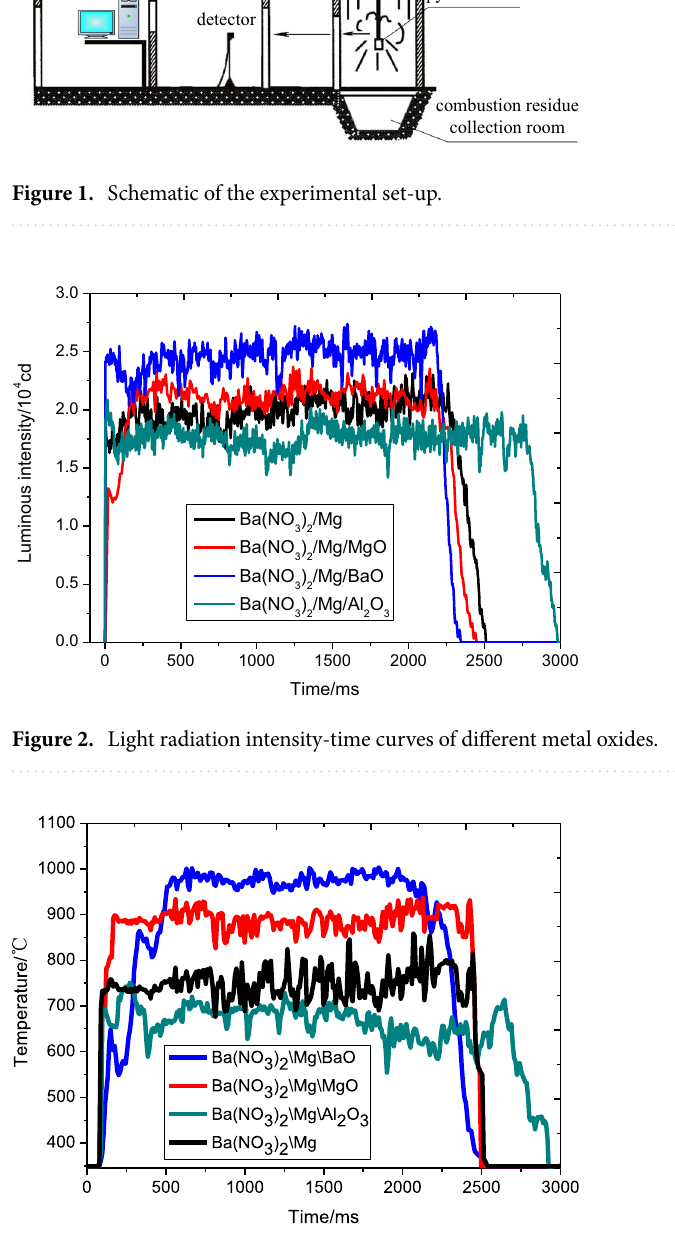
Figure 3. Burning temperature–time curves of different metal oxides.